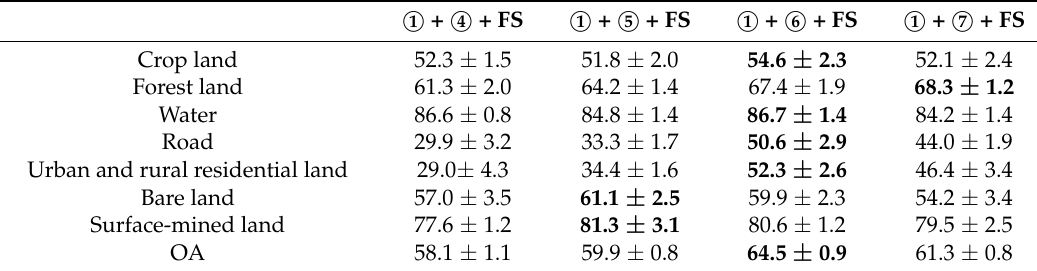
Table 11. The F1-measure and overall accuracy (OA) (%) for land cover classification in complex surface-mined landscapes using SBs and some types of feature sets with feature selection (FS): 1 (cid:13) : spectral bands; 4 (cid:13) : the Gaussian low-pass filters; 5 (cid:13) : the mean filters; 6 (cid:13) : the standard deviation filters; and 7 (cid:13) : texture measures. The bold values represent the best F1-measures and OA values. The accuracies with standard deviation were averaged on 10 runs.